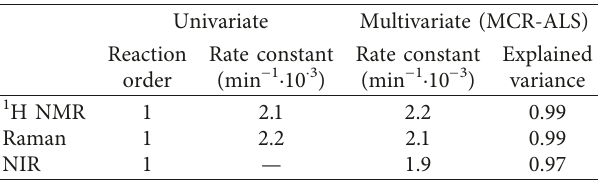
Figure 5: c-t plots as area-under-the-curve vs. time of the enzyme catalysed esterification from univariate data analysis and corresponding fits computed according to first-order reaction based on NMR (a) and Raman (b) spectra; acetic acid (blue), acetic anhydride (orange), and isoamyl acetate (yellow). Table 1: Reaction order and rate constants according to 1 H NMR, Raman, and NIR spectroscopic methods for the enzyme-catalysed hydrolysis of acetic anhydride using univariate and multivariate spectral